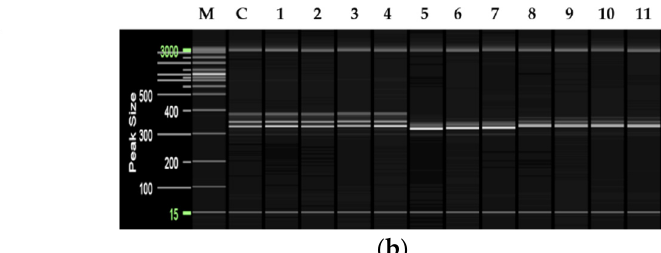
Figure 3. Simple sequence repeat (SSR) molecular analysis of the control and regenerated plants obtained using anther culture. Polymerase chain reaction analysis using the primers ( a ) BM-CiSSR-P2; ( b ) BM-CiSSR-253. M, molecular marker (20 and 100 bp DNA ladder); C, control plant; lanes 2–11, regenerated plants obtained through anther culture.